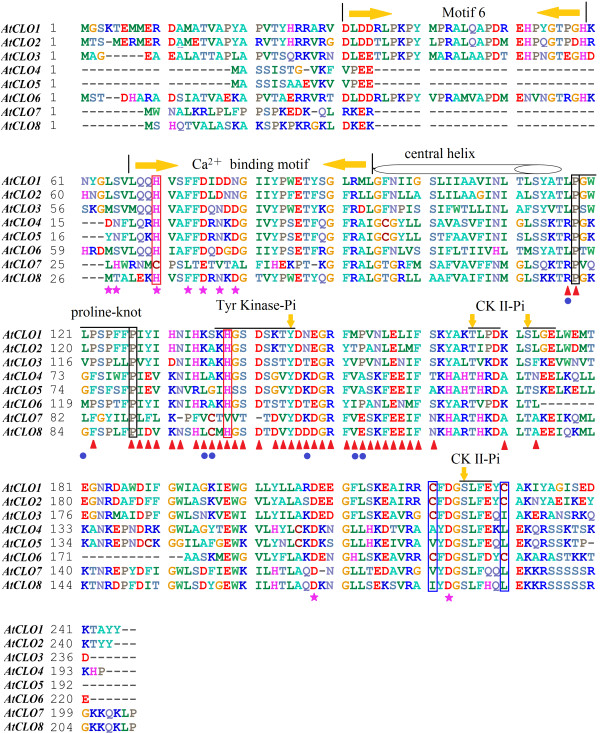
Multiple sequence alignment of Arabidopsis caleosin protein sequences. The positions of the motif 6, a calcium-binding motif, a proline knot-like motif, and four phosphorylation sites (one tyrosine kinase and three casein kinase II phosphorylation sites) are indicated on the tops of the sequences. The two invariable proline residues in the proline knot-like motif are labeled by black boxes, two His sites and two Cys sites of dissulfide bridge are highlighted by red and blue frames, respectively. The consensus sequence of the phosphorylation sites are marked by upper lines with the potential phosphorylated residue pointed by arrows. The critical amino acid sites of functional divergence, adaptive selection and coevolution are marked by red triangles, blue circles, and purple stars, respectively.